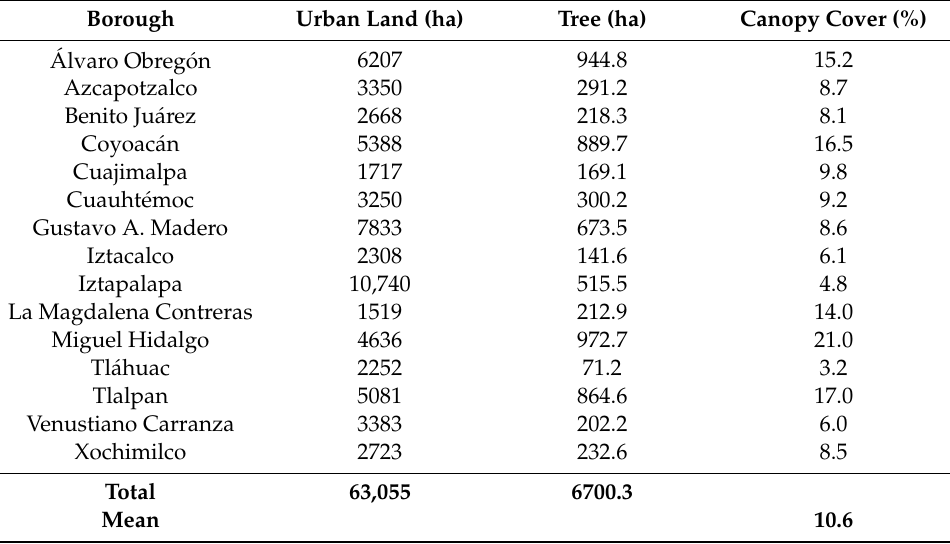
Table 4. Estimated canopy cover in 15 Mexico City boroughs.